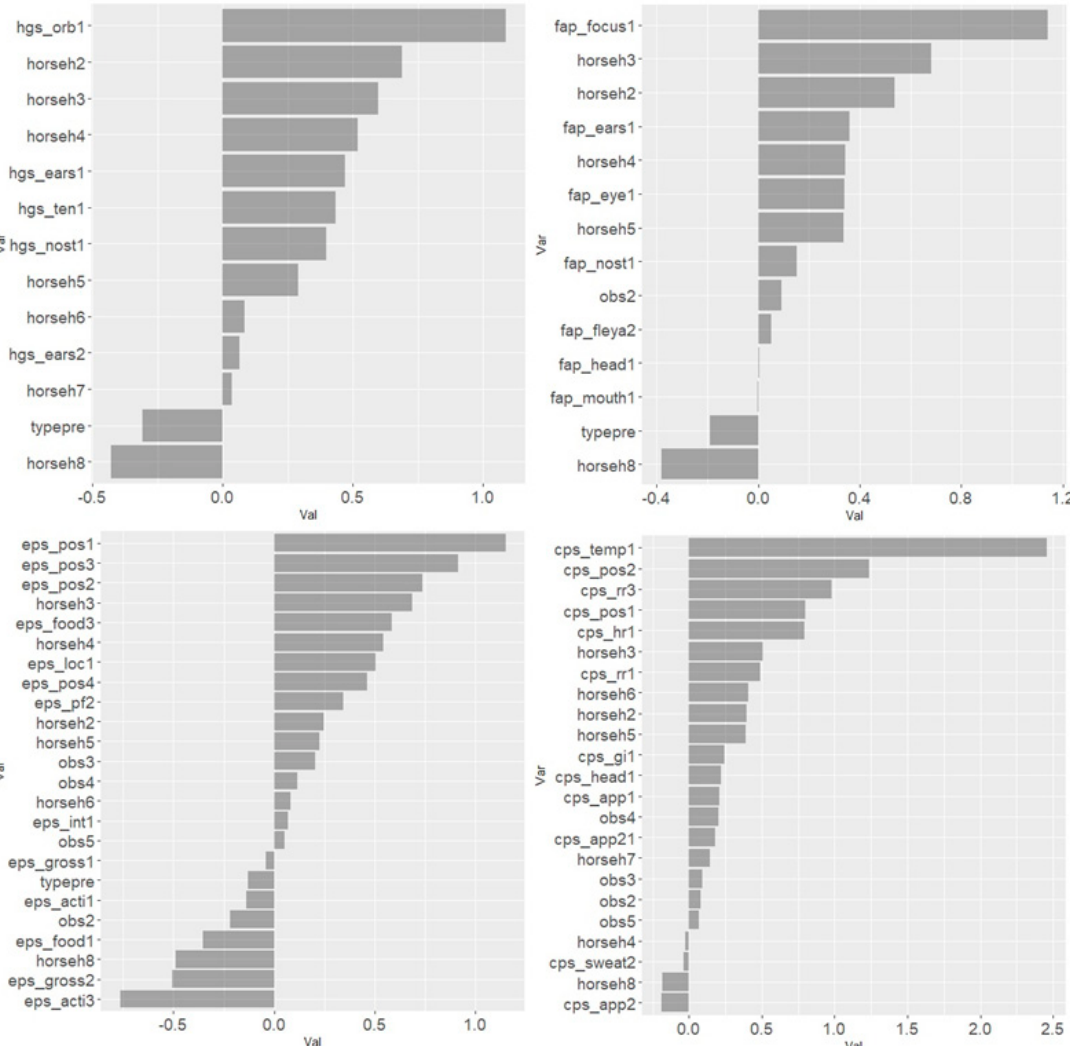
Figure 5. Coefficient of Lasso regression models with lambdas generating the minimum mean cross-validated error when using scale items to predict movement asymmetry. Scale items from the four equine pain scales (Horse Grimace Scale (HGS), Equine Utrecht University Scale of Facial Assessment of Pain (EQUUS-FAP), Equine Pain Scale (EPS) and Composite Pain Scale (CPS)) were analyzed in separate models. Scale items with a positive coefficient (to the right) were positively associated with total asymmetry score, used here as a proxy for orthopedic pain. The number after the scale item is the item score, for example hgs_orb1 means an item score of 1 for orbital tightening in the HGS.